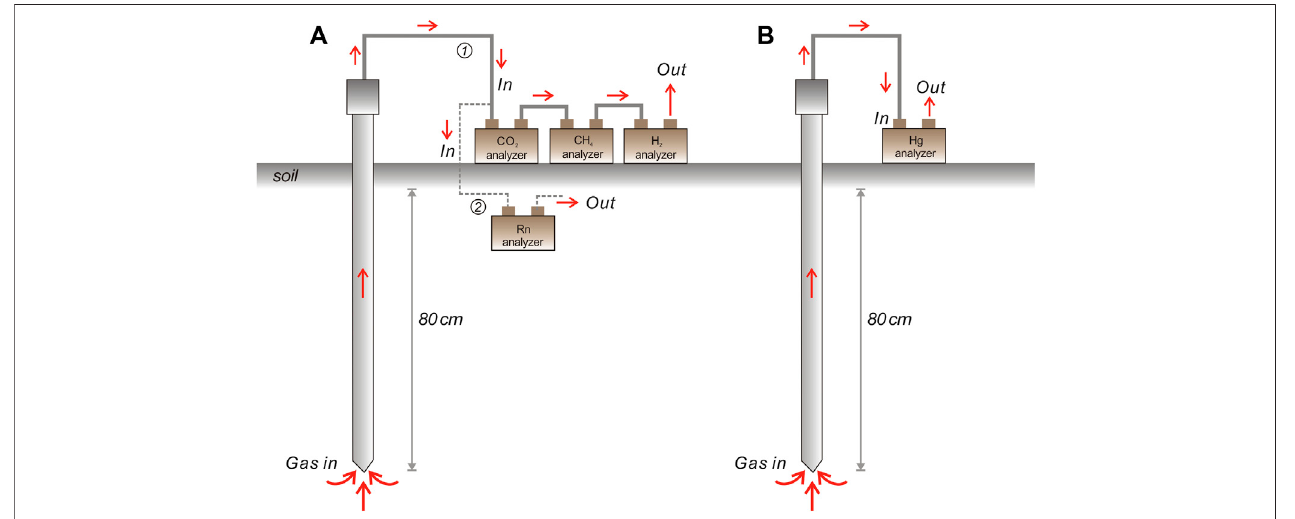
FIGURE 2 | Sketch map showing the measurement method of soil gases in the XXFS. ① and ② represent the fi rst and second steps of the measurement at S1. Details of the measurement method can be found in the text.